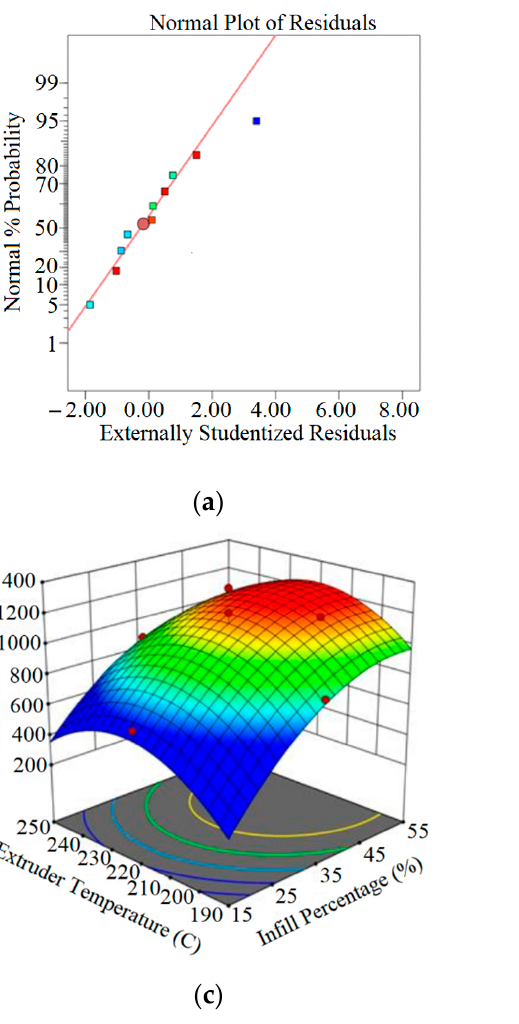
Figure 6. Response surface plots for FL: ( a ) normal plot of residuals, ( b ) predicted vs. actual output, ( c ) response surface plot, and ( d ) contour plot of IP and ET. Table 6. Analysis of variance (ANOVA) for